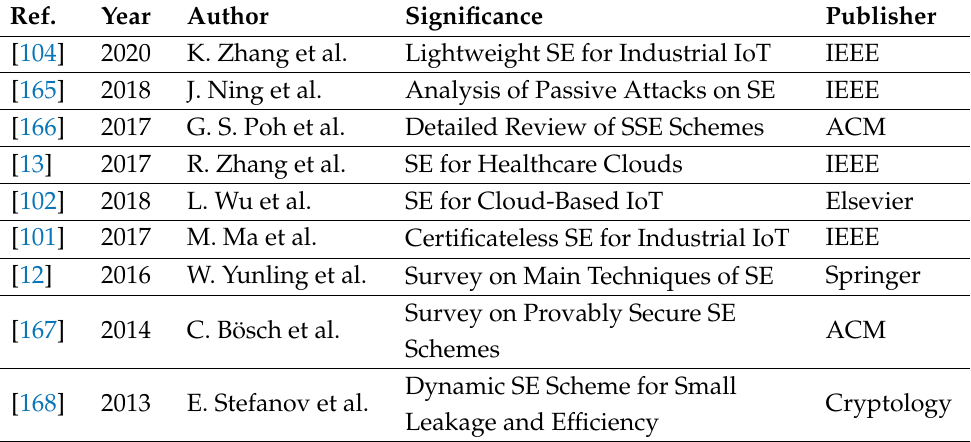
Table 4. Significant literature for SE in the last decade.